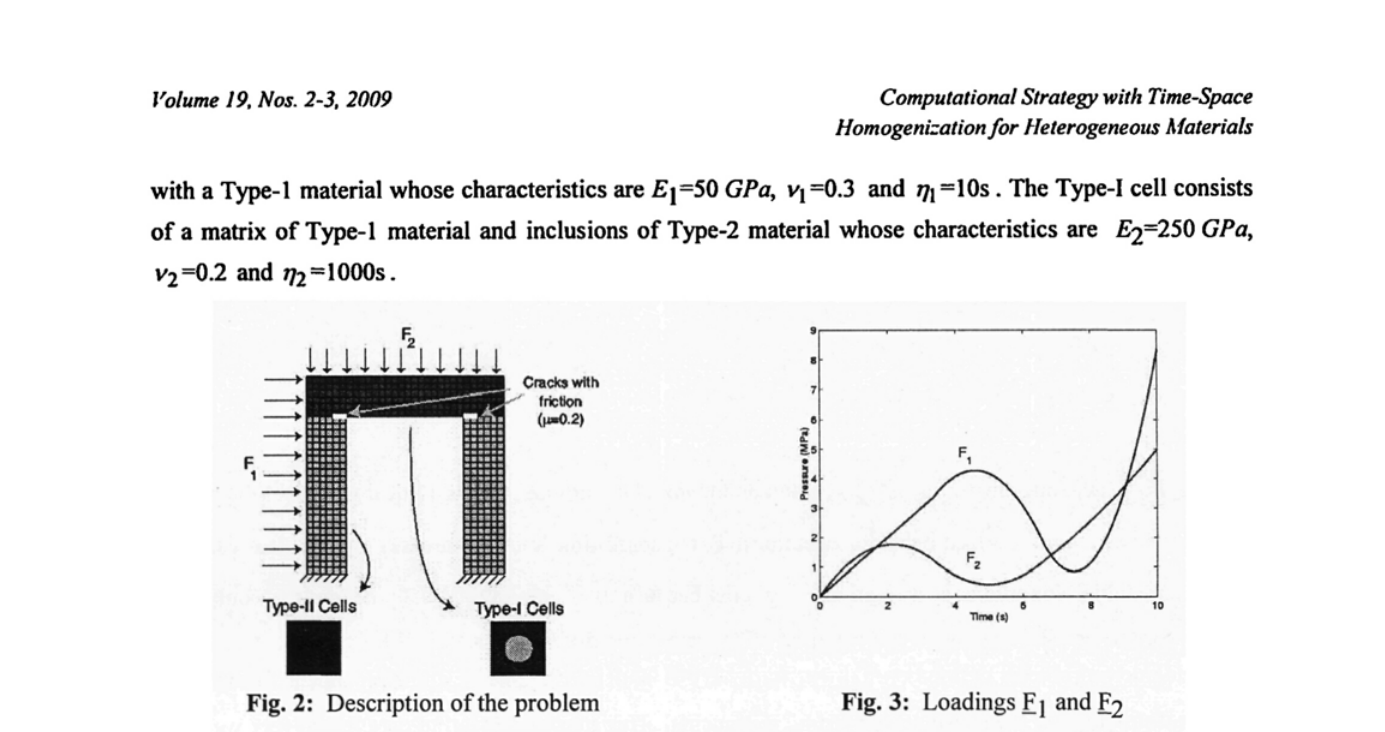
Fig. 2: Description of the problem Fig. 3: Loadings Fj and F